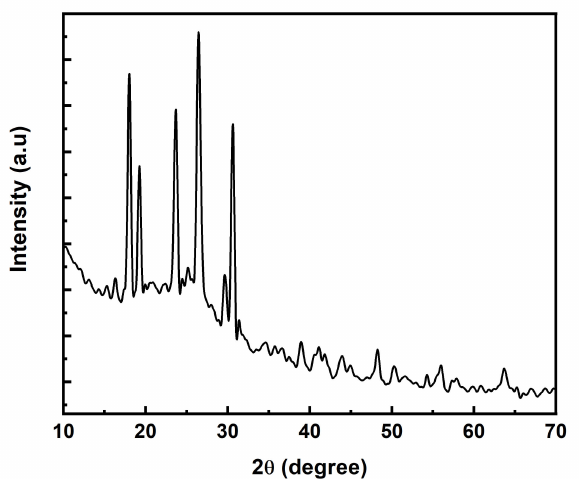
Figure 4. XRD spectrum of sodium phytate doped